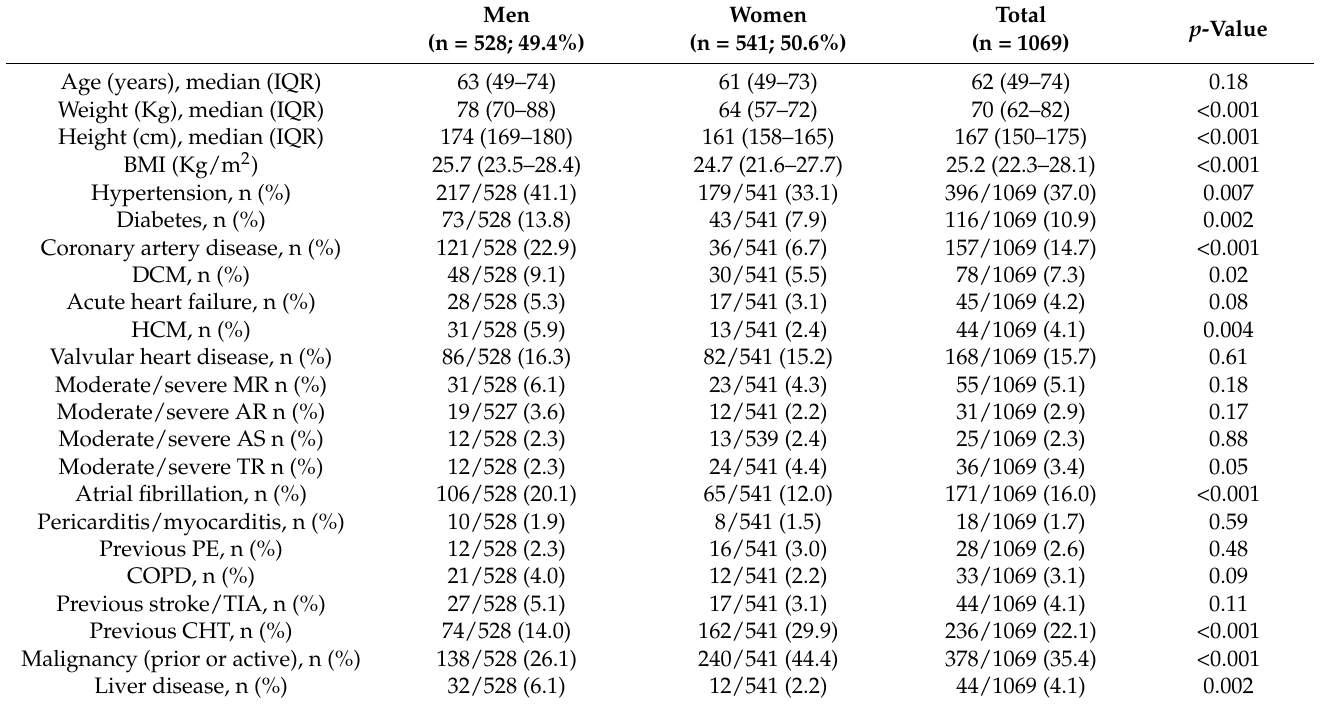
Table 1. Baseline clinical characteristics stratified by biological